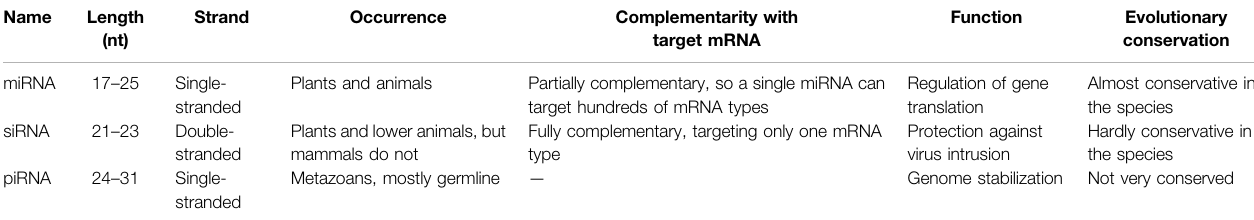
TABLE 1 | Comparison of different small